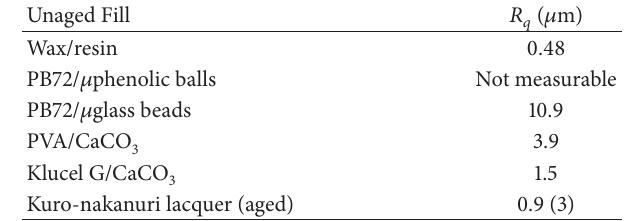
Table 4: Surface roughness, 𝑅 𝑞